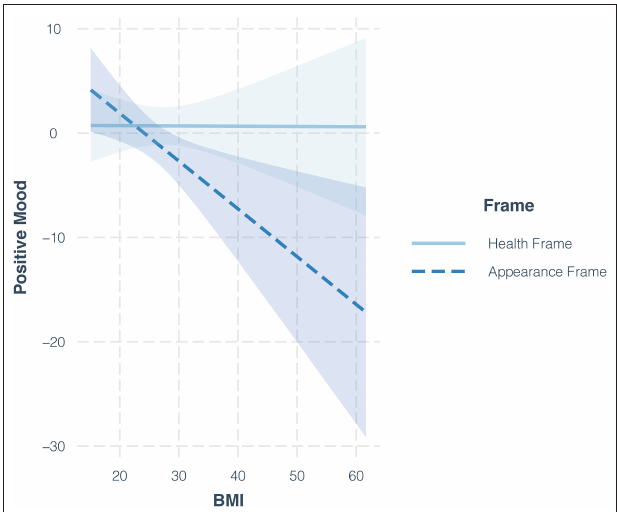
FIGURE 1 | Interaction effects of the frame and level of BMI of the participants on positive